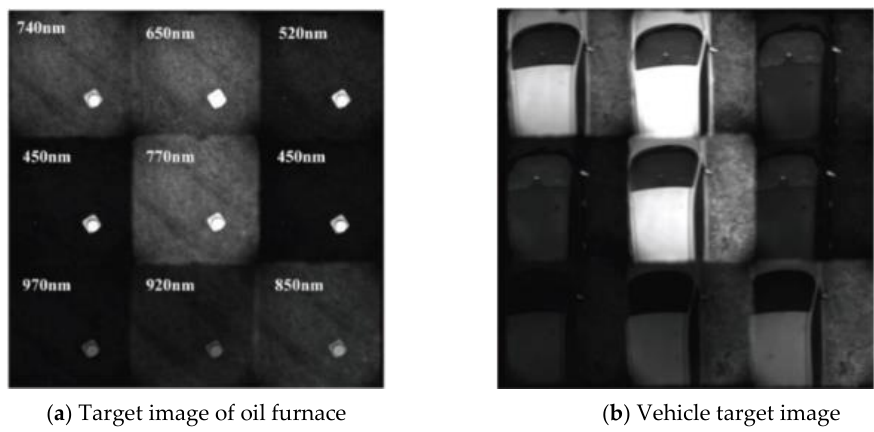
Figure 22. Aerial images obtained with the mobile TOMBO system: ( a ) oil stove and ( b ) car.